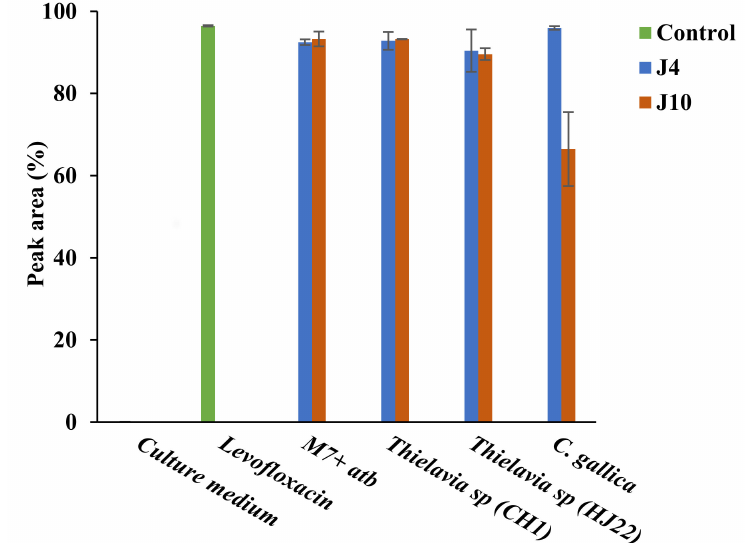
Figure 3. Levofloxacin degradation by the 3 fungal strains on Day 4 (blue) and Day 10 (orange) of culture. Controls were culture medium alone (M7), levofloxacin at 50 mg L − 1 in water (green) and culture medium (M7) with 50 mg L − 1 of levofloxacin (at days 4 and 10). Each datapoint (mean ± standard deviation) is the result of triplicate